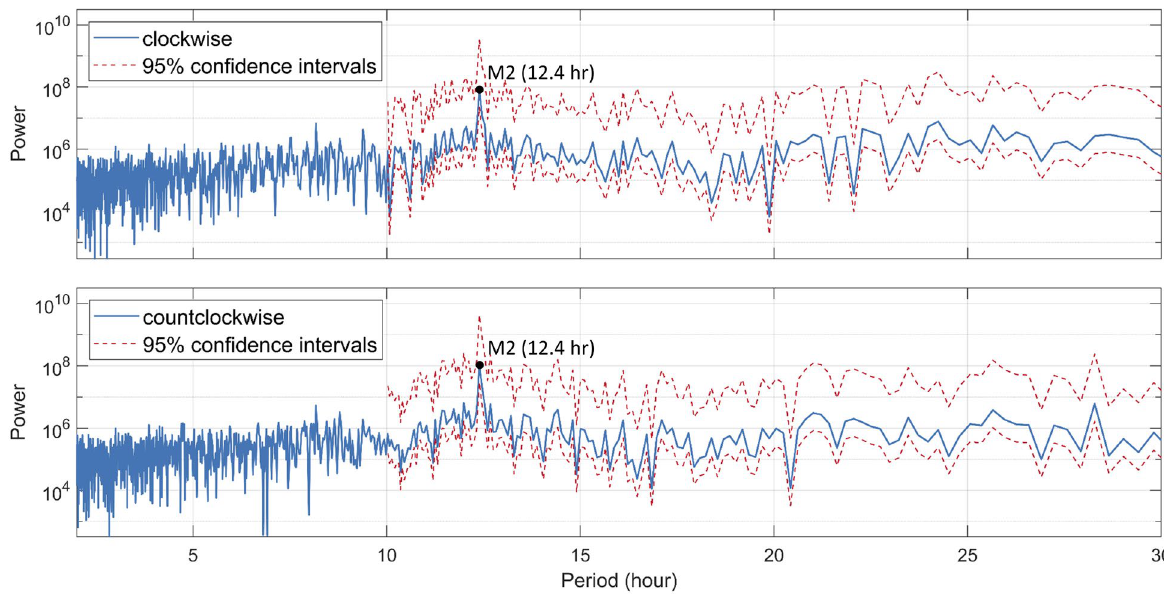
Figure 13. Rotary power spectrum of HF radar in northern Taiwan (26°N, 122°E).